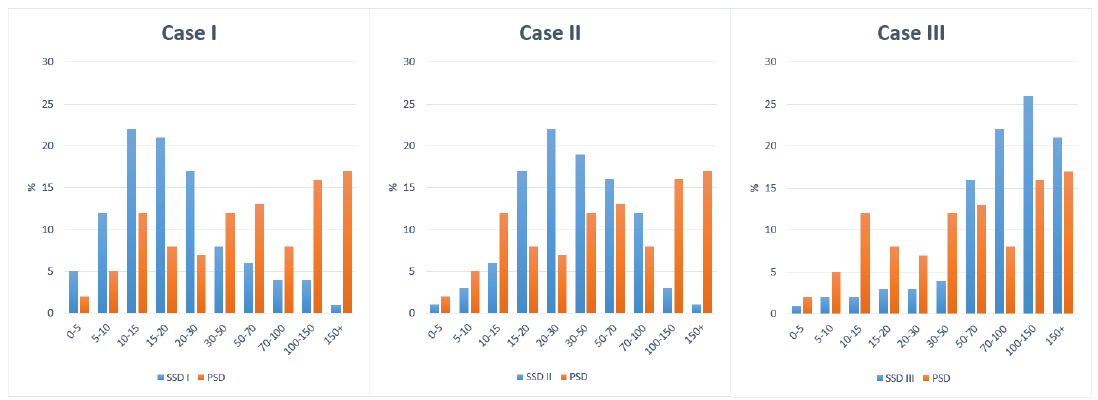
Figure 3. Comparison of suspended solids distribution and pore size distribution. Porosity reduction based on IR for all three cases is shown in Table 2. Porosity reduction based on impairment ratio (IR) for all three cases.